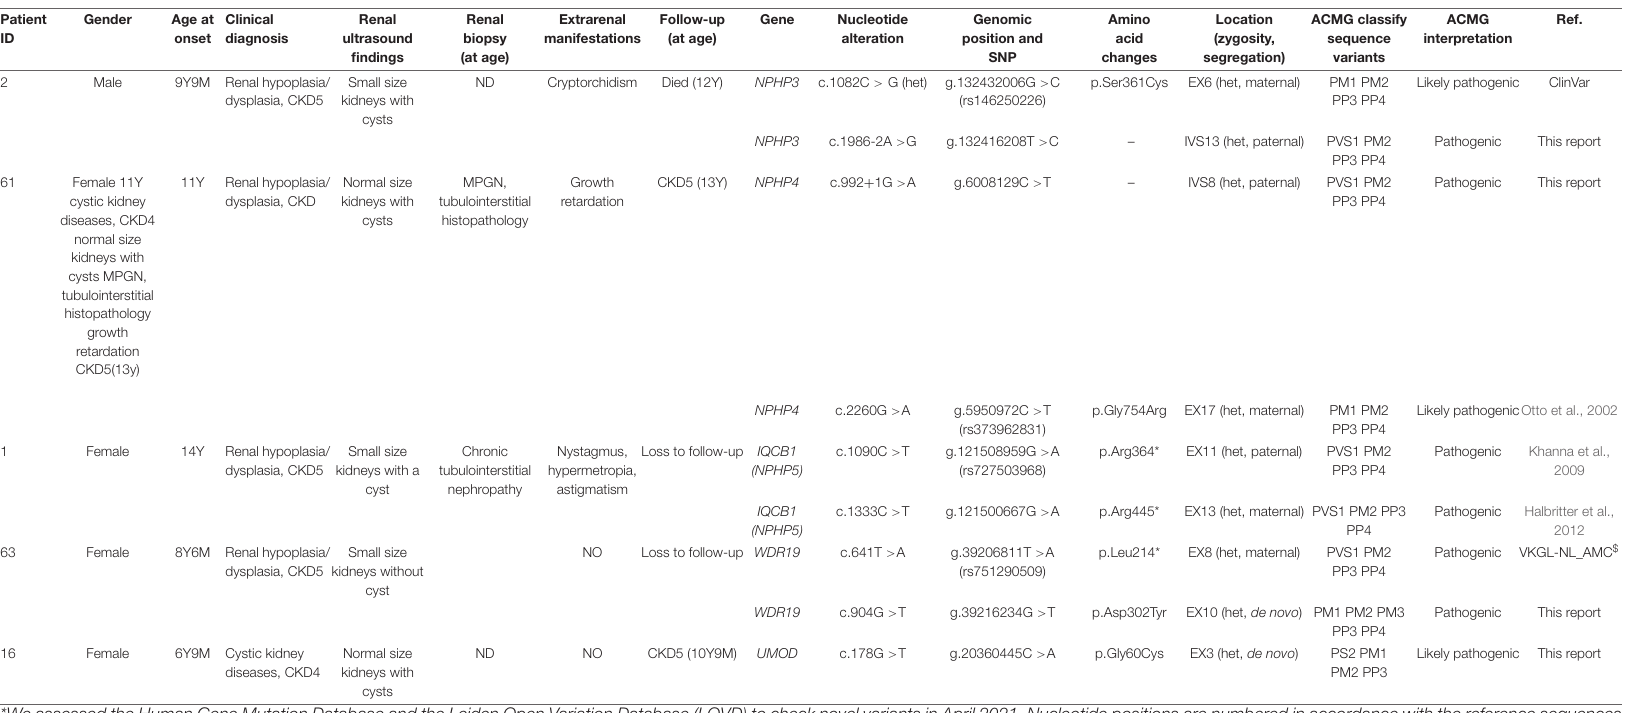
*We assessed the Human Gene Mutation Database and the Leiden Open Variation Database (LOVD) to check novel variants in April 2021. Nucleotide positions are numbered in accordance with the reference sequences (NM_000789.3 for ACE, NM_000458.4 for HNF1B, NM_003990.3 for PAX2, NM_000272.3 for NPHP1, NM_014425.3 for INVS, NM_153240.4 for NPHP3, NM_015102.3 for NPHP4, NM_001023570.2 for IQCB1, NM_025132.3 for WDR19, and NM_003361.2 for UMOD) using the first coding ATG of exon 1 as the initiation codon. Patients 8, 10, 13, 18, 21, 24, 30, 32, 34, and 38 have already been reported (Deng et al., 2019). Patients 6, 28, and 29 have also been reported (Wang et al., 2017a). Patients 23 and 31 have also been reported (Deng et al., 2020). $